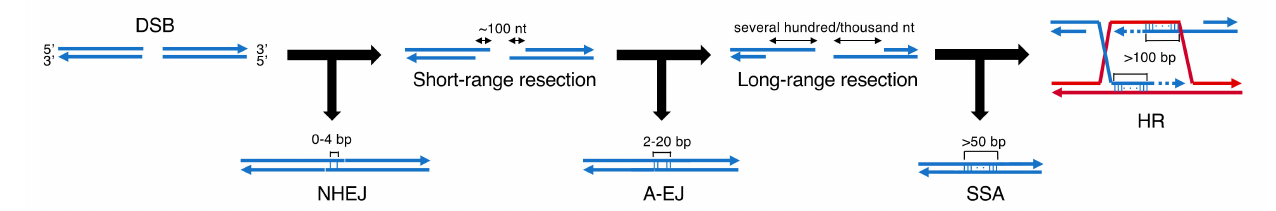
Figure 1. DNA double-strand break pathways. DSB: DNA double-strand break, NHEJ: non-homologous end joining, A-EJ: alternative end joining, SSA: single-strand annealing, HR: homologous